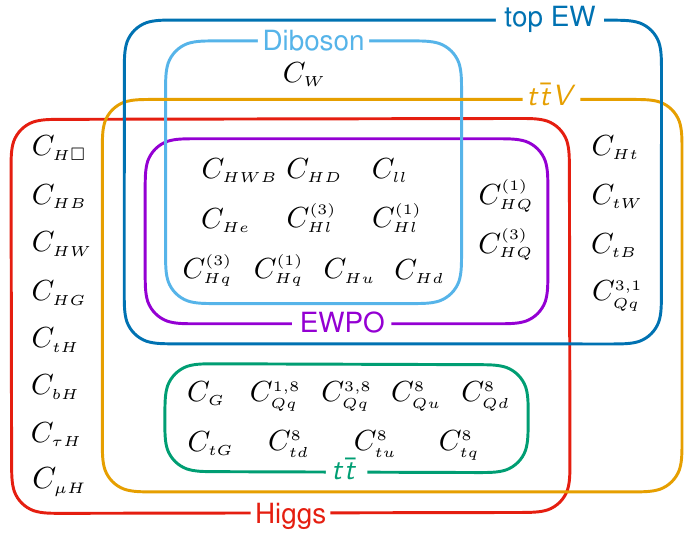
Figure 1 . Schematic representation of the datasets and their overlapping dependences on the 34 Wilson coefficients included in our